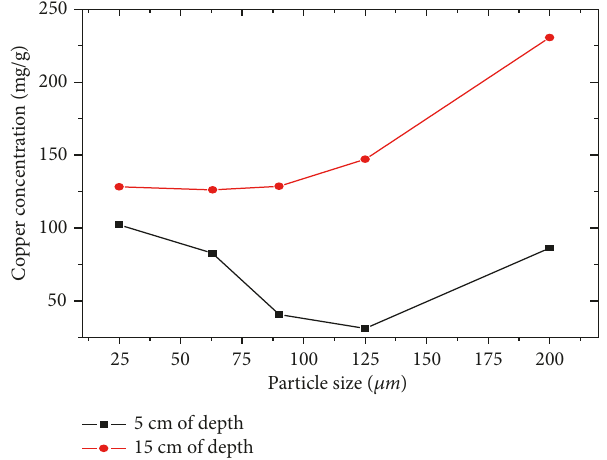
Figure7:Evolutionofcopperconcentrationasafunctionofparticle size and